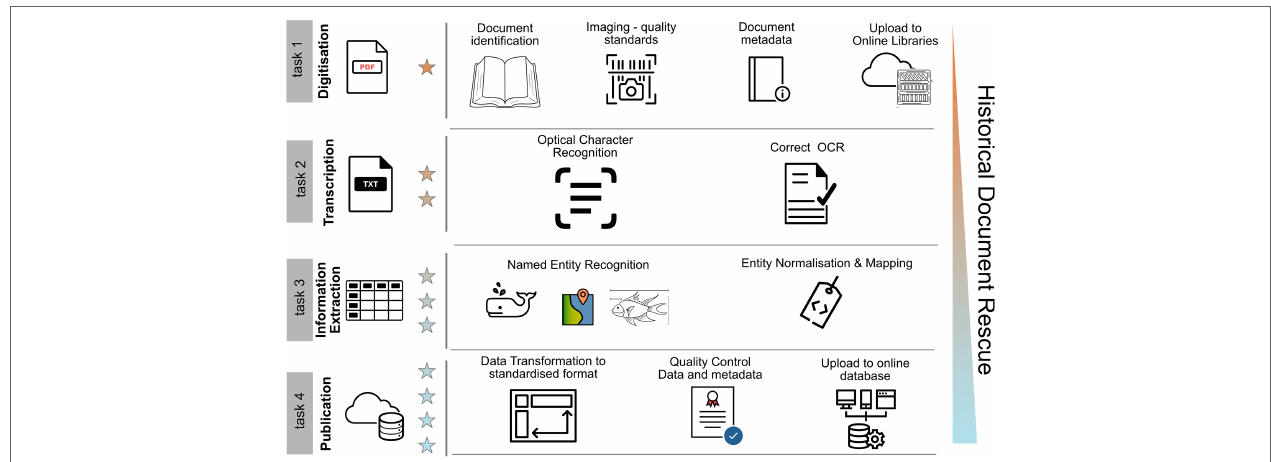
FIGURE 1 | Summarised process of historical document rescue. Four tasks are required to complete the data rescue process of biodiversity documents. Each of these has several steps, methodology, tools and standards. Curation is needed in every task, for tool handling and error correction. The stars represent the 5-star ranking system of Linked Data as introduced by W3C 7 (Heath and Bizer, 2011). Availability of information from historical data increases as the curation tasks are completed (as exemplified by the fan on the right). Icons used from the Noun Project released under CC BY: book by Oleksandr Panasovskyi, scanning by LAFS, Book info by Xinh Studio, Library by ibrandify, Scanner Text by Wolf Böse, Check form by allex, Whale by Alina Oleynik, Fish by Asmuh, tag code vigorn, pivot layout by paisan, Certificate by P Thanga Vignesh, web service by